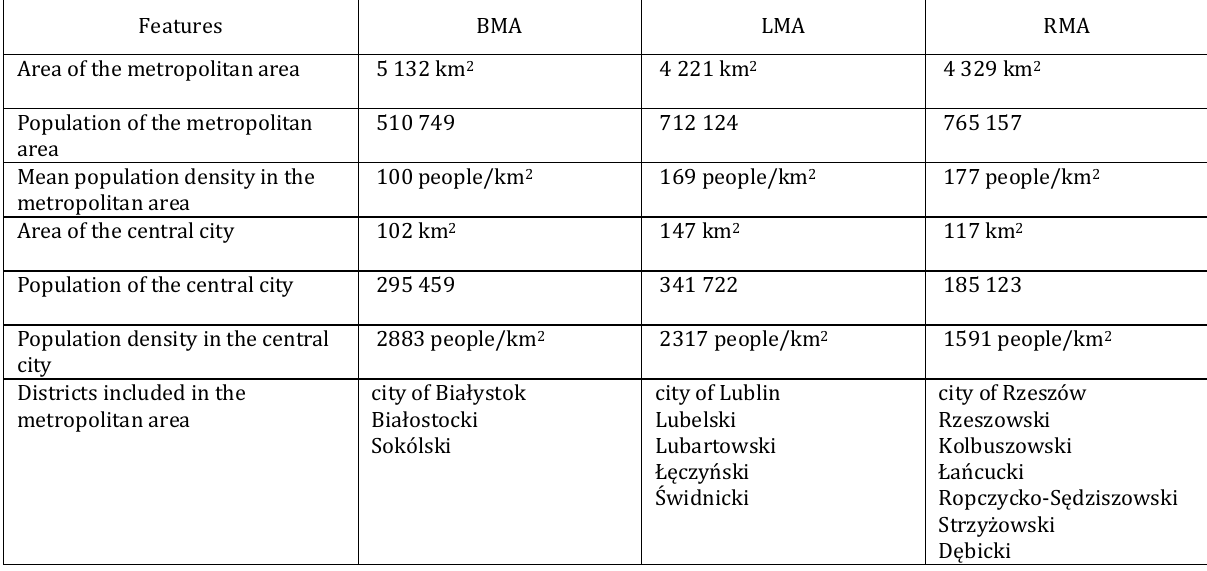
Table 2. Descriptions of the metropolitan areas of Lublin, Białystok and Rzeszów (2014) (author’s own elaboration based on data of the Central Statistical Office,